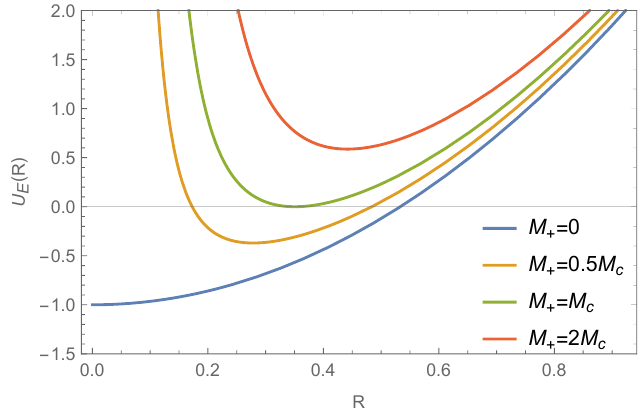
Figure 1 . The effective potential U E ( R ) of the bubble nucleation in Schwarzschild black hole for different black hole mass M + . In this plot, G = 1 , L − = 1 , and σ = 1 mass is M c = 0 . 00967 . When 0 < M + < M c , the effective potential has two intersections with the R axial. When M + > M c , there is no intersection.